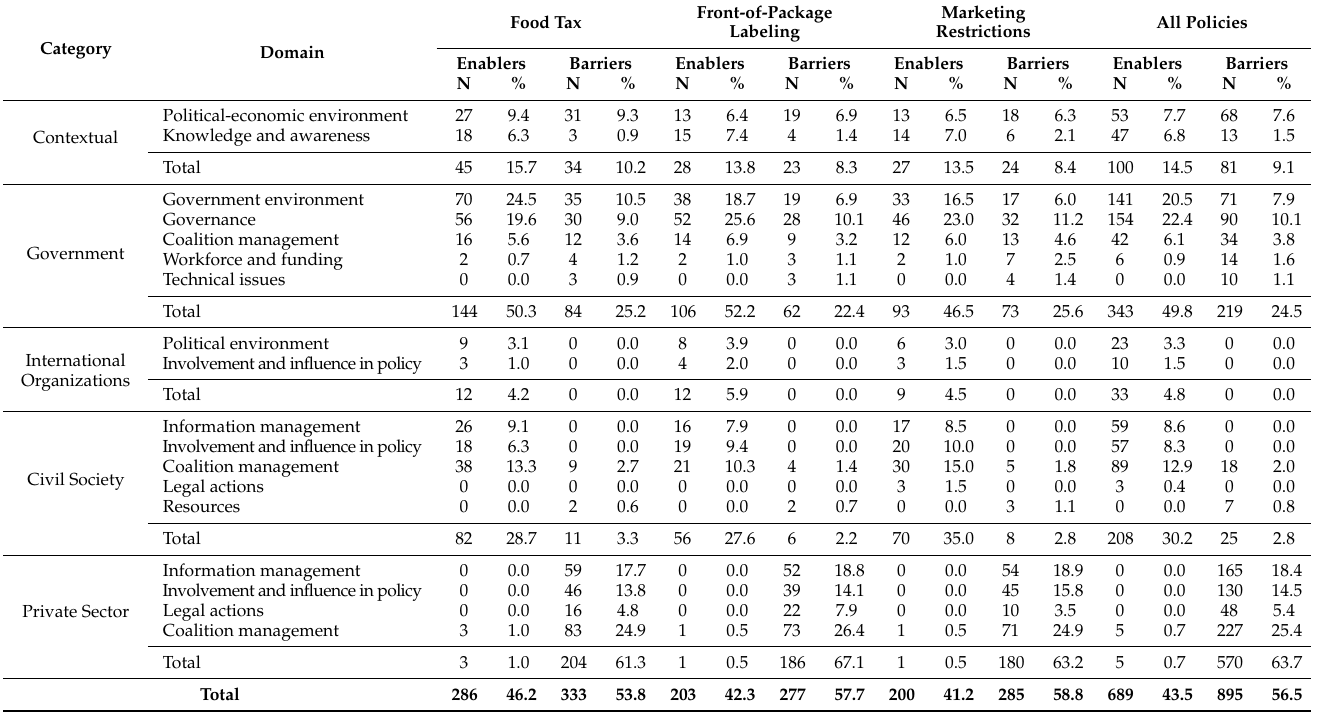
Table 3. Number and percentage of document characteristics by food